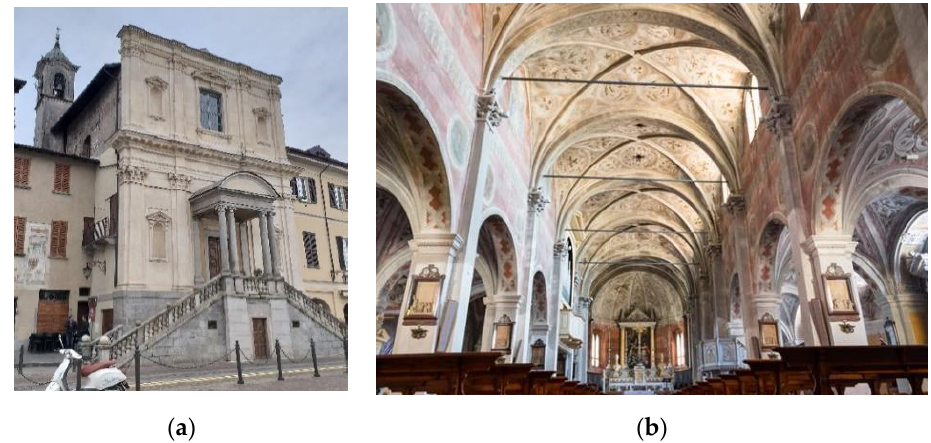
Figure 1. Case studies used in the present research: ( a ) St. Marta in Arona and ( b ) St. Bassiano in Pizzighettone (CR).